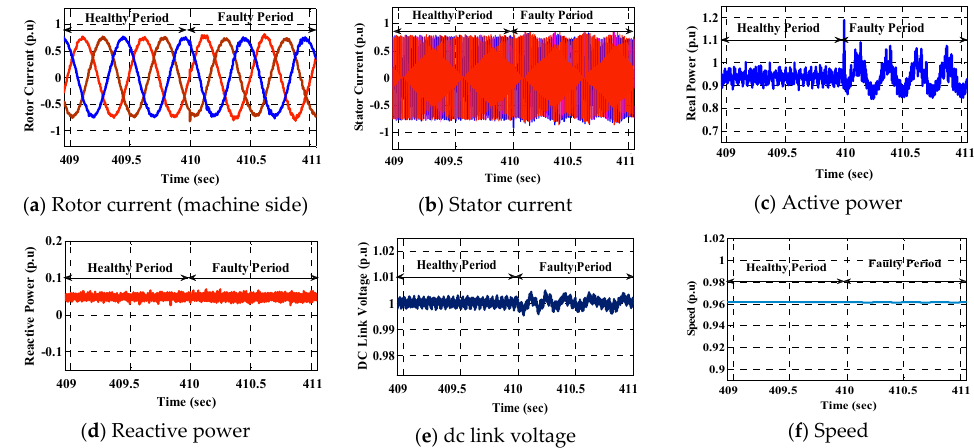
Figure 4. Single rotor current sensor omission fault for a 250-MW DFIM unit.